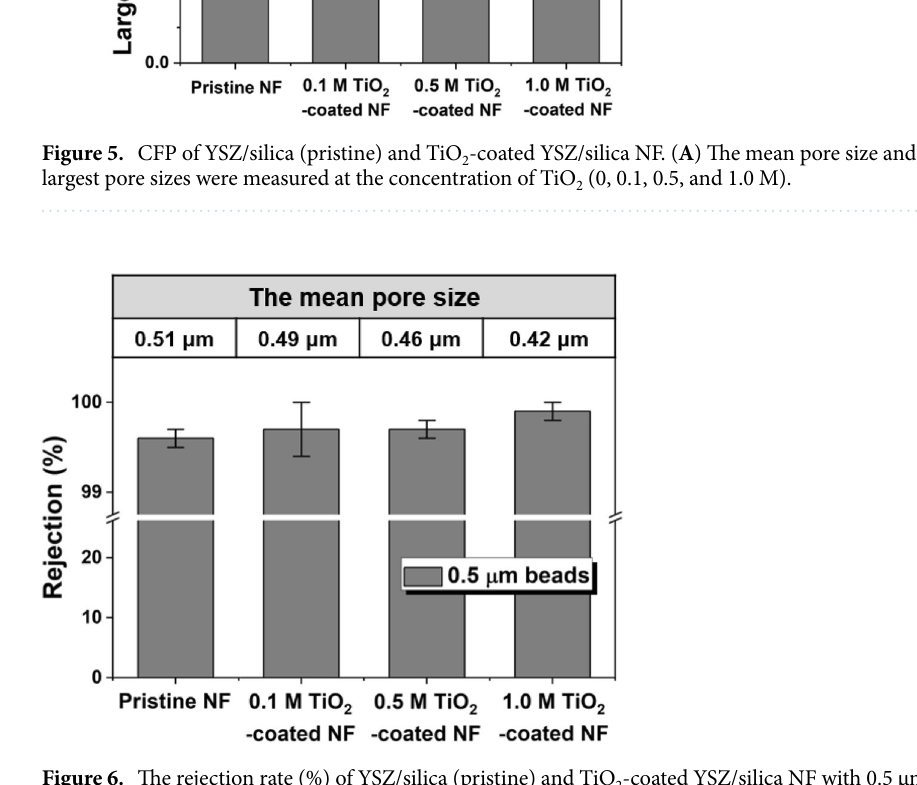
rejection rates (%) is due to the mean pore size of TiO 2 -coated YSZ/silica NF membranes, which was mostly less than 0.5 μm as shown in Fig. 5A. However, the mean pore size of the YSZ/silica NF membrane was 0.51 μm, which was almost equal to or larger than the diameter of the polymeric particles (0.5 μm), but it was measured at a high rejection rate (%) of approximately 99.6% ± 0.1%. This is observed because the structure of the YSZ/ silica NF membrane is so intricately entangled into several layers that the polymeric particles undergo the tor- tuous pathway through the filtration process 14 . The variation in the rejection rate (%) is directly correlated to a